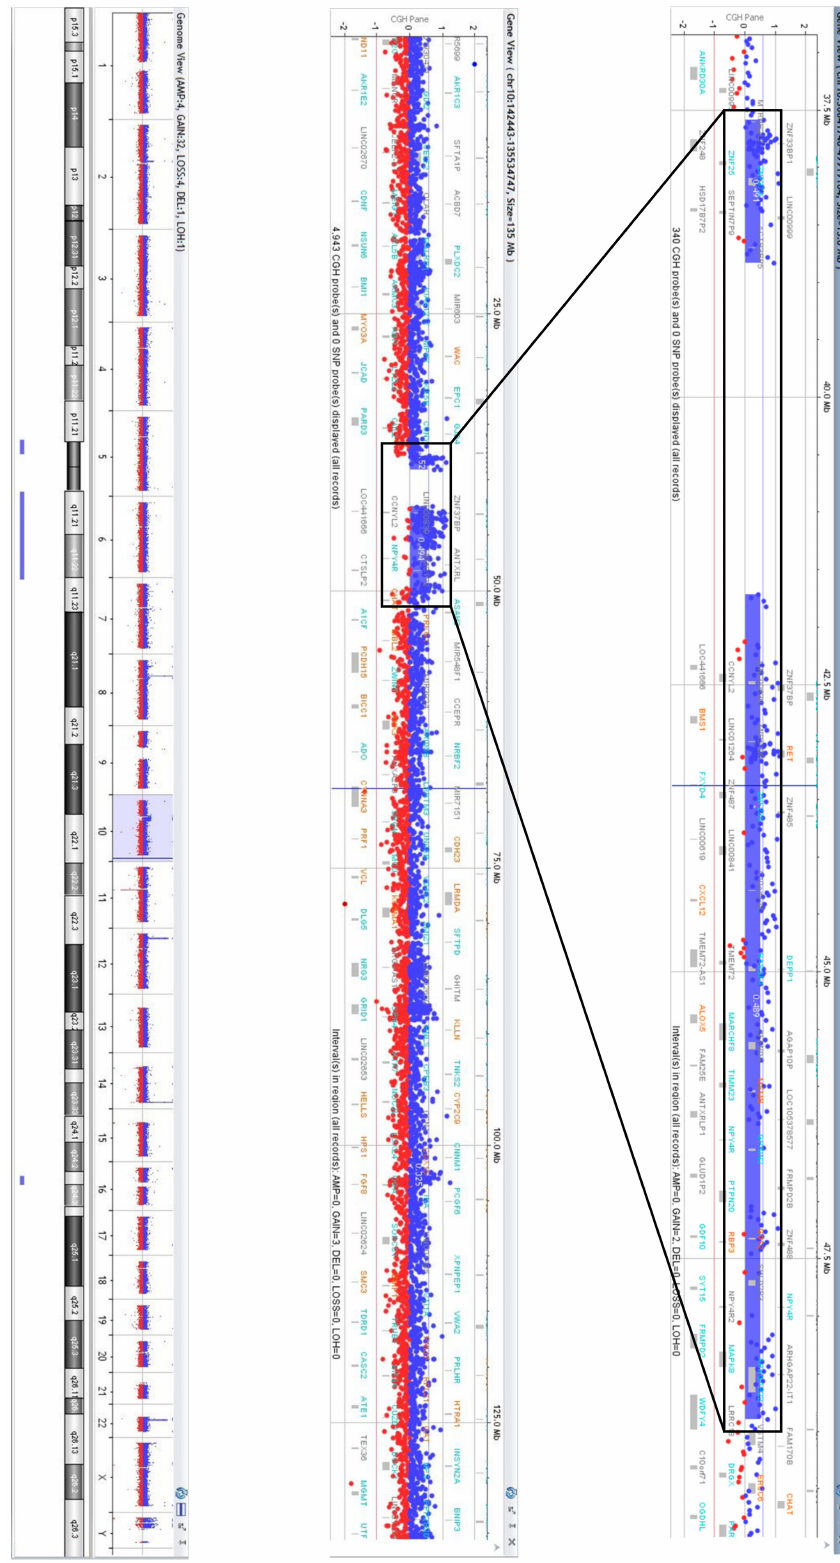
Figure 7. aCGH profile showing a gain on chromosome 10 in 10p11.21-p11.1 and 10q11.21-q11.23. The numbers in the axis of aCGH profiles represent log2 ratios of fluorescent intensity of tested (blue signal) and control (red signal) DNA probes. A log2-ratio of 0 corresponds to a balanced copy number; 1.0 represents the